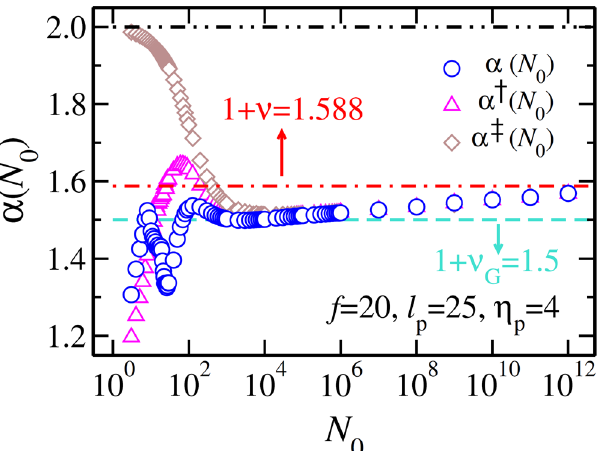
Figure 4. The effective translocation time exponents as a function of the chain length N 0 for =  25 friction η p = 4, and external driving force f = 20. The blue circles show the translocation exponent α as a function of N 0 , while pink triangles and brown diamonds show the rescaled translocation exponents α † and α ‡ , respectively. The horizontal black dashed-dotted-dotted, red dashed-dotted and turquoise dashed lines show the asymptotic rod-like, excluded volume chain and Gaussian scaling limits, respectively. See text for